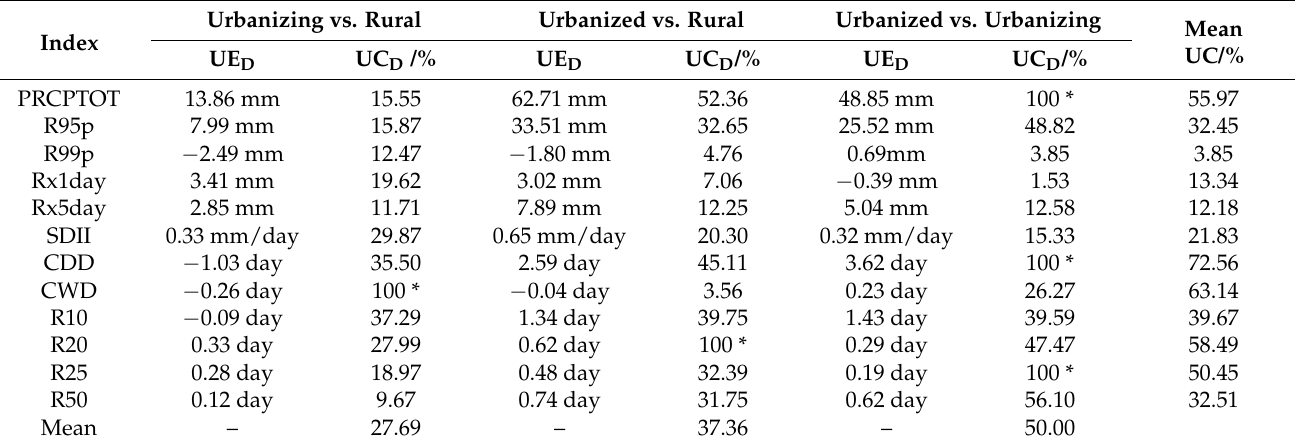
Table 3. Results of urbanization effect and contribution based on the urban–rural difference series.